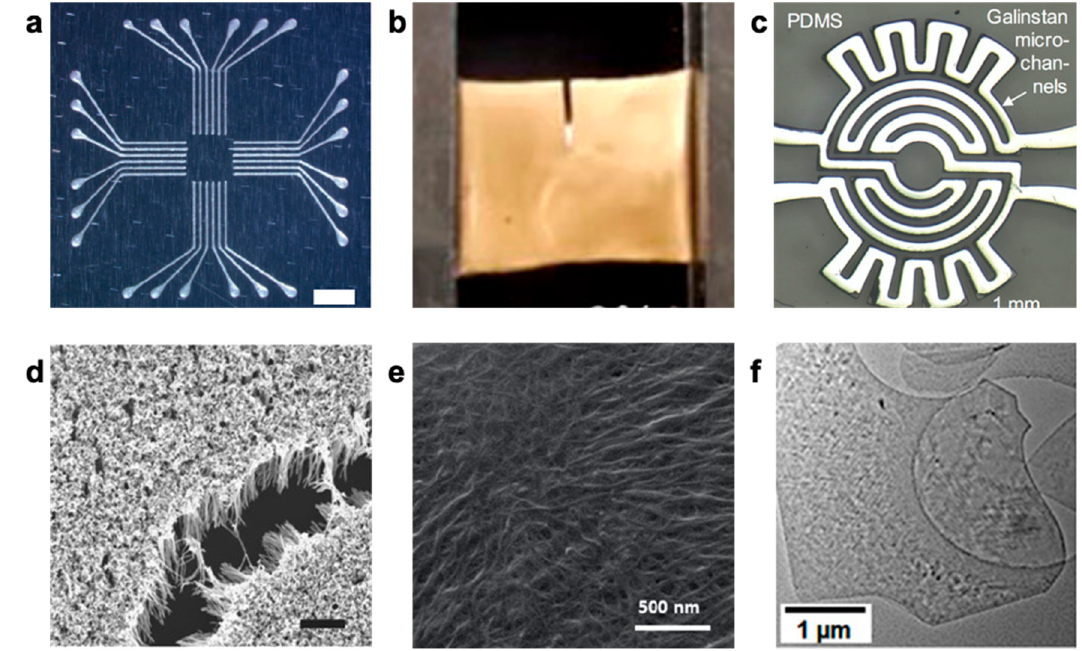
Figure 3. Various active materials for stretchable electronics. ( a ) Silver flake / polyurethane ink. ( b ) Gold thin film. ( c ) Liquid metal. ( d ) Gold nanowires. ( e ) Carbon nanotubes (CNTs). ( f ) MXene